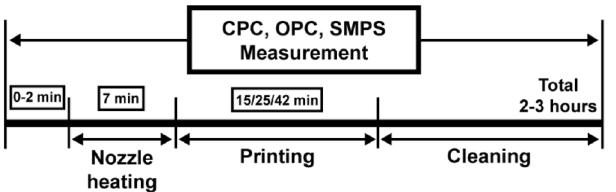
Figure 3. Schedule of an emission test including nozzle heating, printing, and cleaning